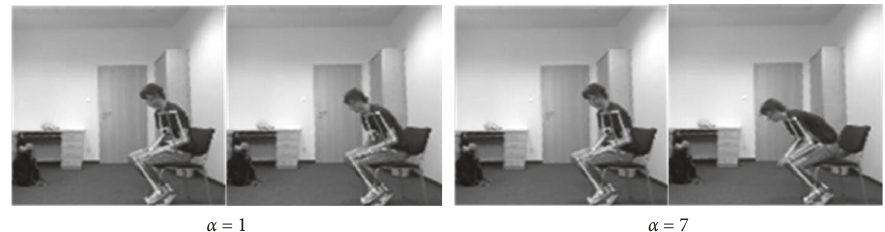
Figure 1: Cosine-aware hash flow